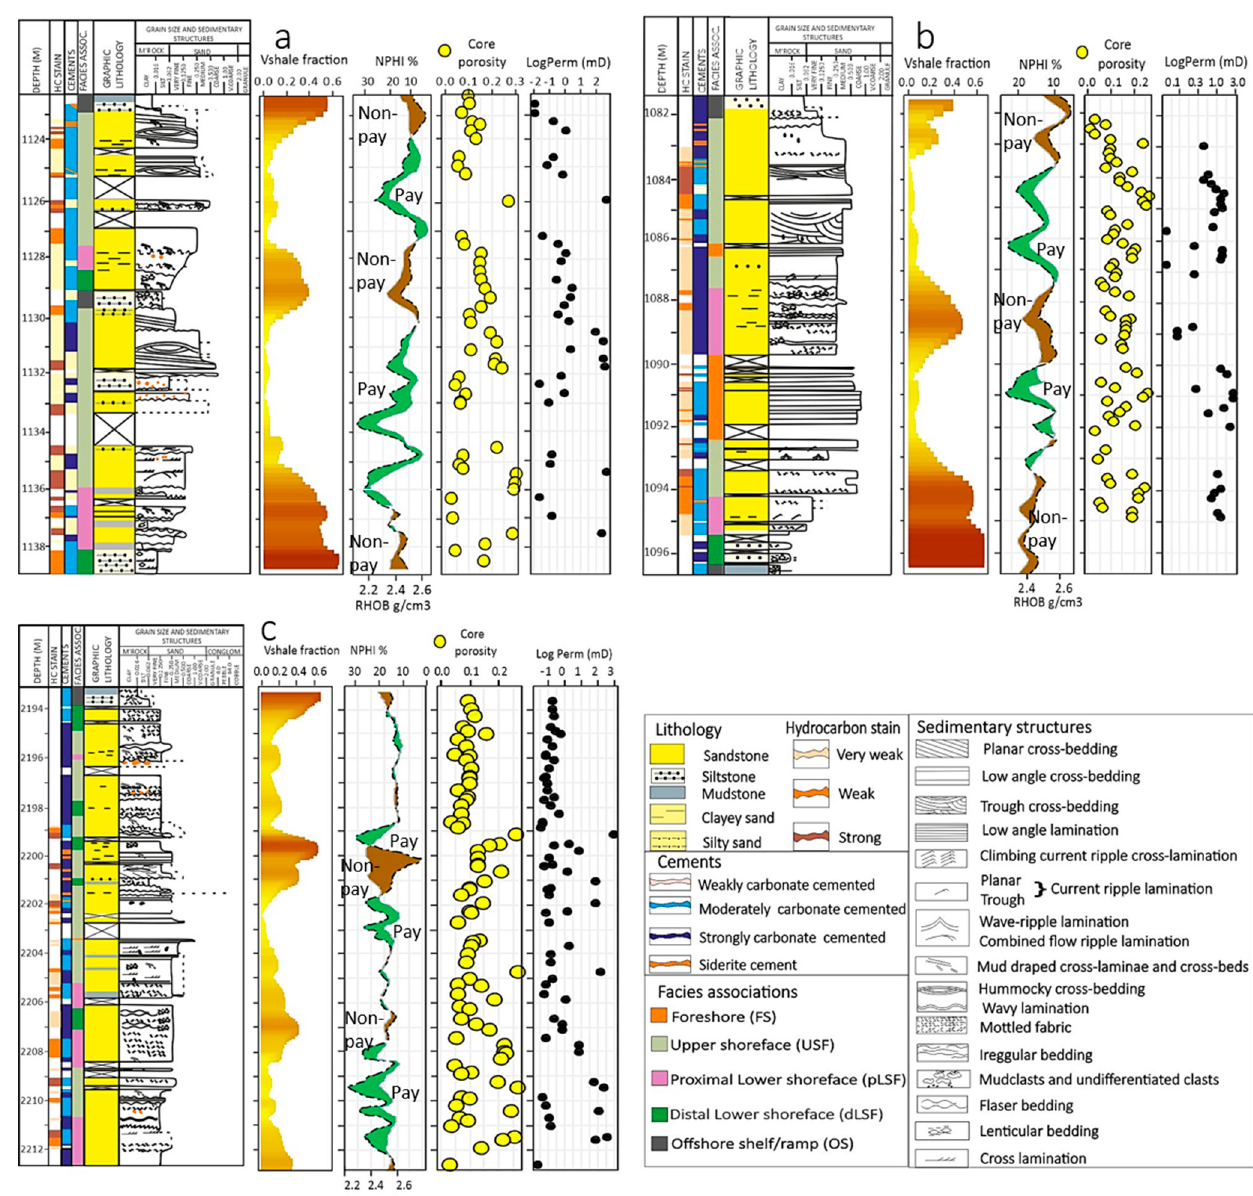
Figure 4. Shows sedimentary log, Vshale log, neutron (NPHI) and density (RHOB) cross-over plot, core analysis porosity log and core permeability log for wells, ( a ) PW7, ( b ) PW3, and ( c ) BL5. Sedimentary logs show short-range heterogeneity in sedimentary structures and intensity of cementation. They also show variation in hydrocarbon stains with depth. The wireline logs (Vshale, NPHI and RHOB) track the variation in shale content from the sedimentary logs with the core porosity and permeability logs showing the best reservoir quality sections in the sand-rich portions of the logs. Even though the logs show the highest porosity and permeability in the sandier zones. They also have low porosity and permeability in the sandier zones suggesting that lithology is not the dominant control on reservoir quality. The intervals with high calcite cement and clay content show lower porosity and permeability giving an initial indication of possible reservoir quality controls.